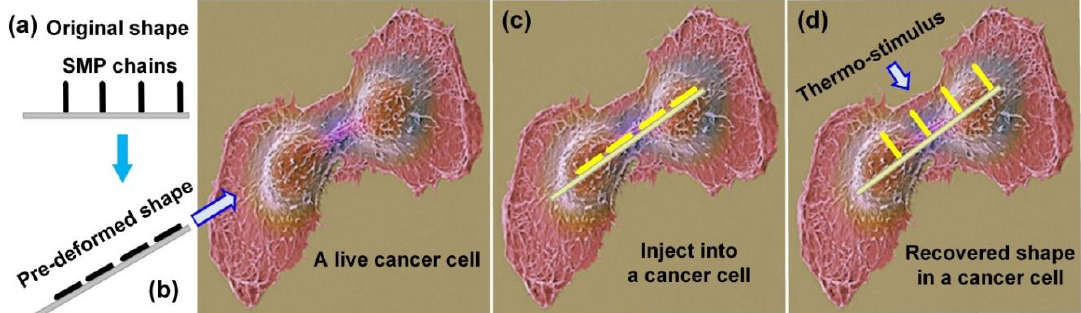
Figure 12. Schematic illustration of the delivery and operation procedure of microscale Shape Memory Polymer (SMP) brush machine in a live cancer cell. (The live cancer cell is referred to in Reference [39]). ( a ) Original shape of SMP chain pillars; ( b ) Pre-deformed SMP chain pillars; ( c ) Pre-deformed SMP chain pillars injected into a cancer cell; ( d ) Recovered SMP chain pillars in a cancer cell.